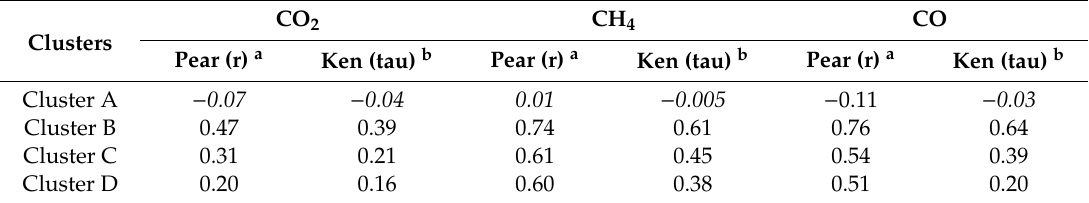
Table 2. Variations in CO 2 , CH 4 , and CO statistically associated with the di ff erent clusters. CO 2 CH 4 CO Clusters Pear (r) a Ken (tau) b Pear (r) a Ken (tau) b Pear (r) a Ken (tau) b Cluster A − 0.07 − 0.04 0.01 −